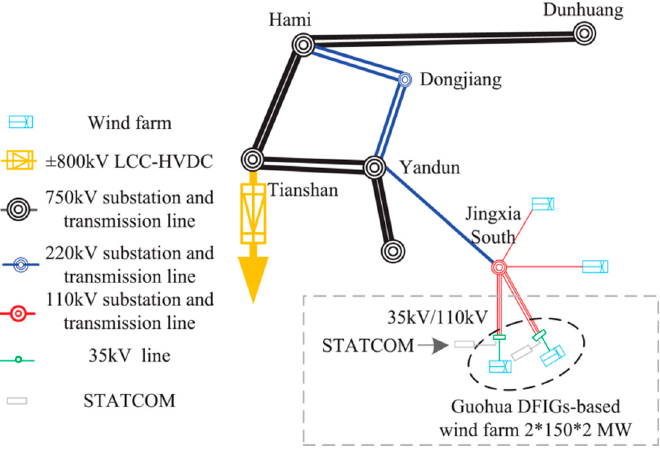
Figure 5. Single line diagram of the wind power system in Xinjiang [5].